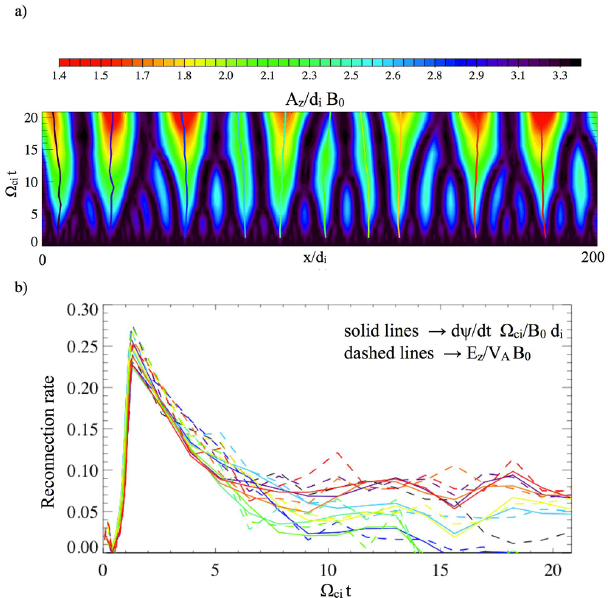
Fig. 1. The stack plot of the out-of-plane vector potential compo- nent A z along the line y = 22 . 5 d i is shown in (a) . The reconnection rate in (b) is calculated as derivative in time of the reconnected flux ψ (solid line) and as E z (dashed lines), for different X points (col- ored lines in a ).